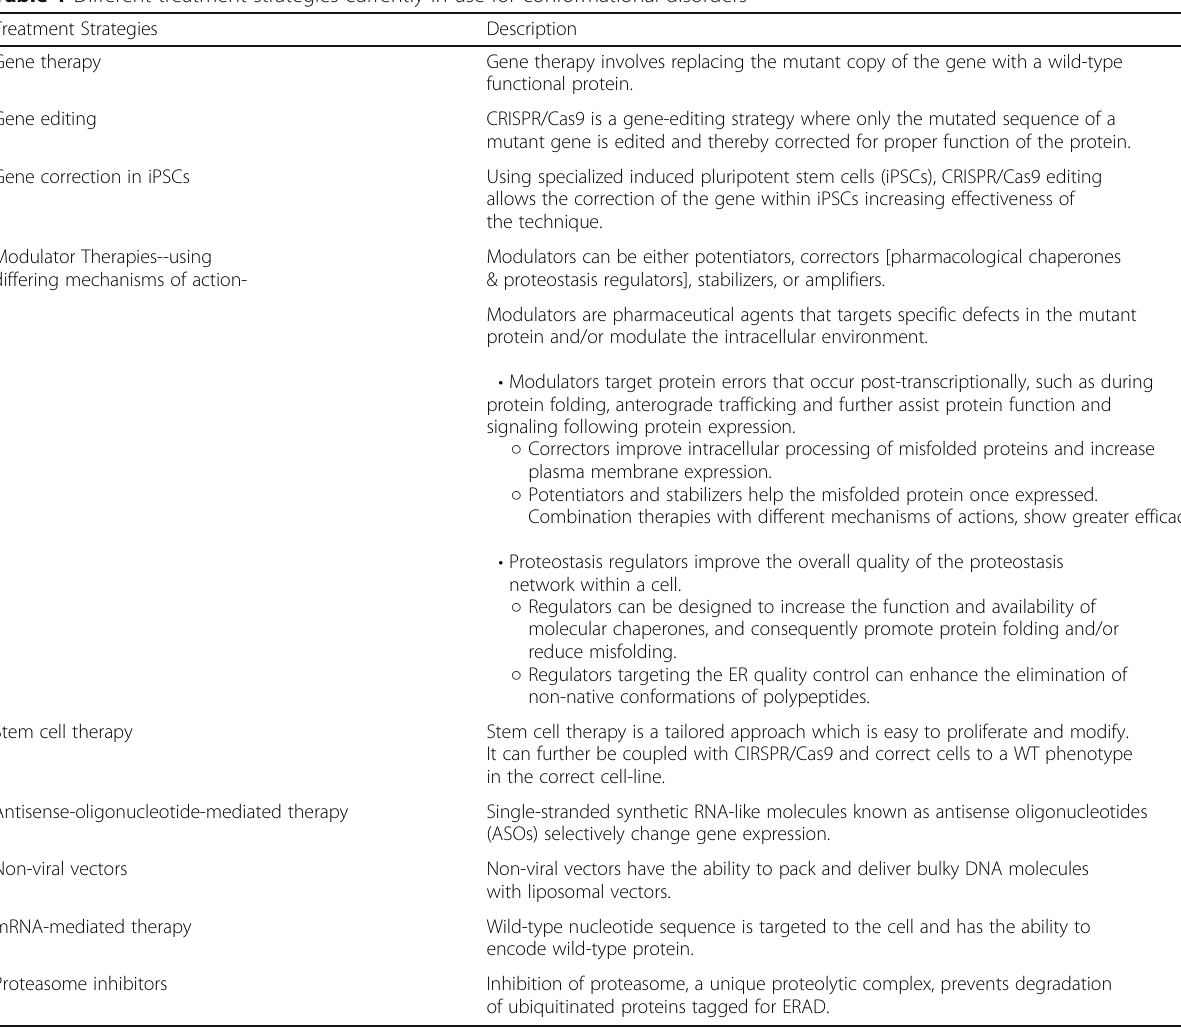
Table 1 Different treatment strategies currently in use for conformational disorders Treatment Strategies